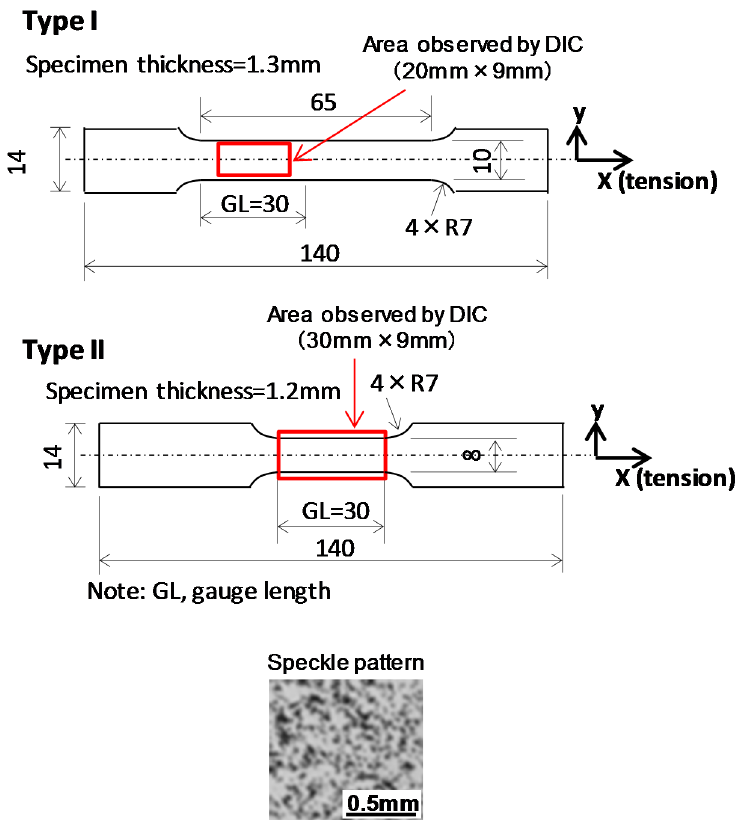
Figure 2. Two types of tension specimen (Type I and Type II) and speckle patterns on the front surface of the specimen.